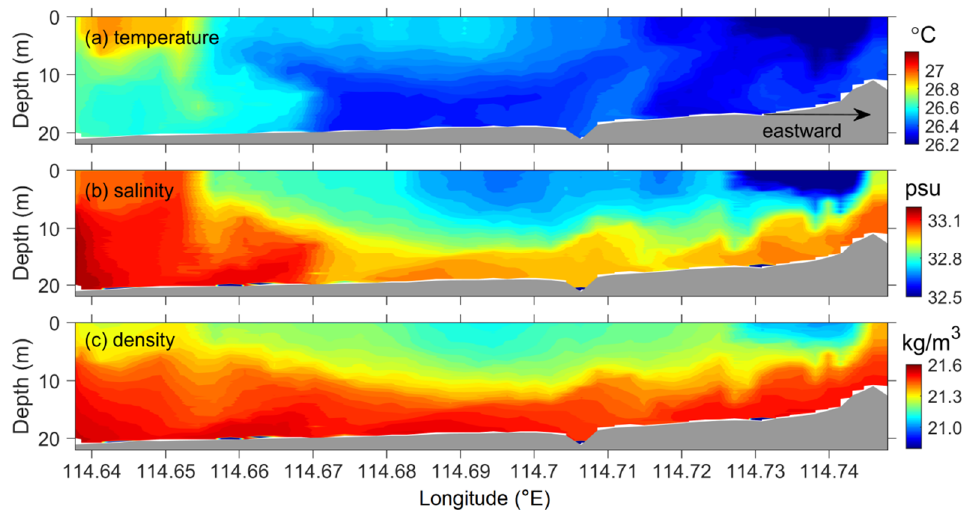
Figure 5. ( a ) Temperature, ( b ) salinity, and ( c ) density along transect S2 as measured by the YODA profiler.